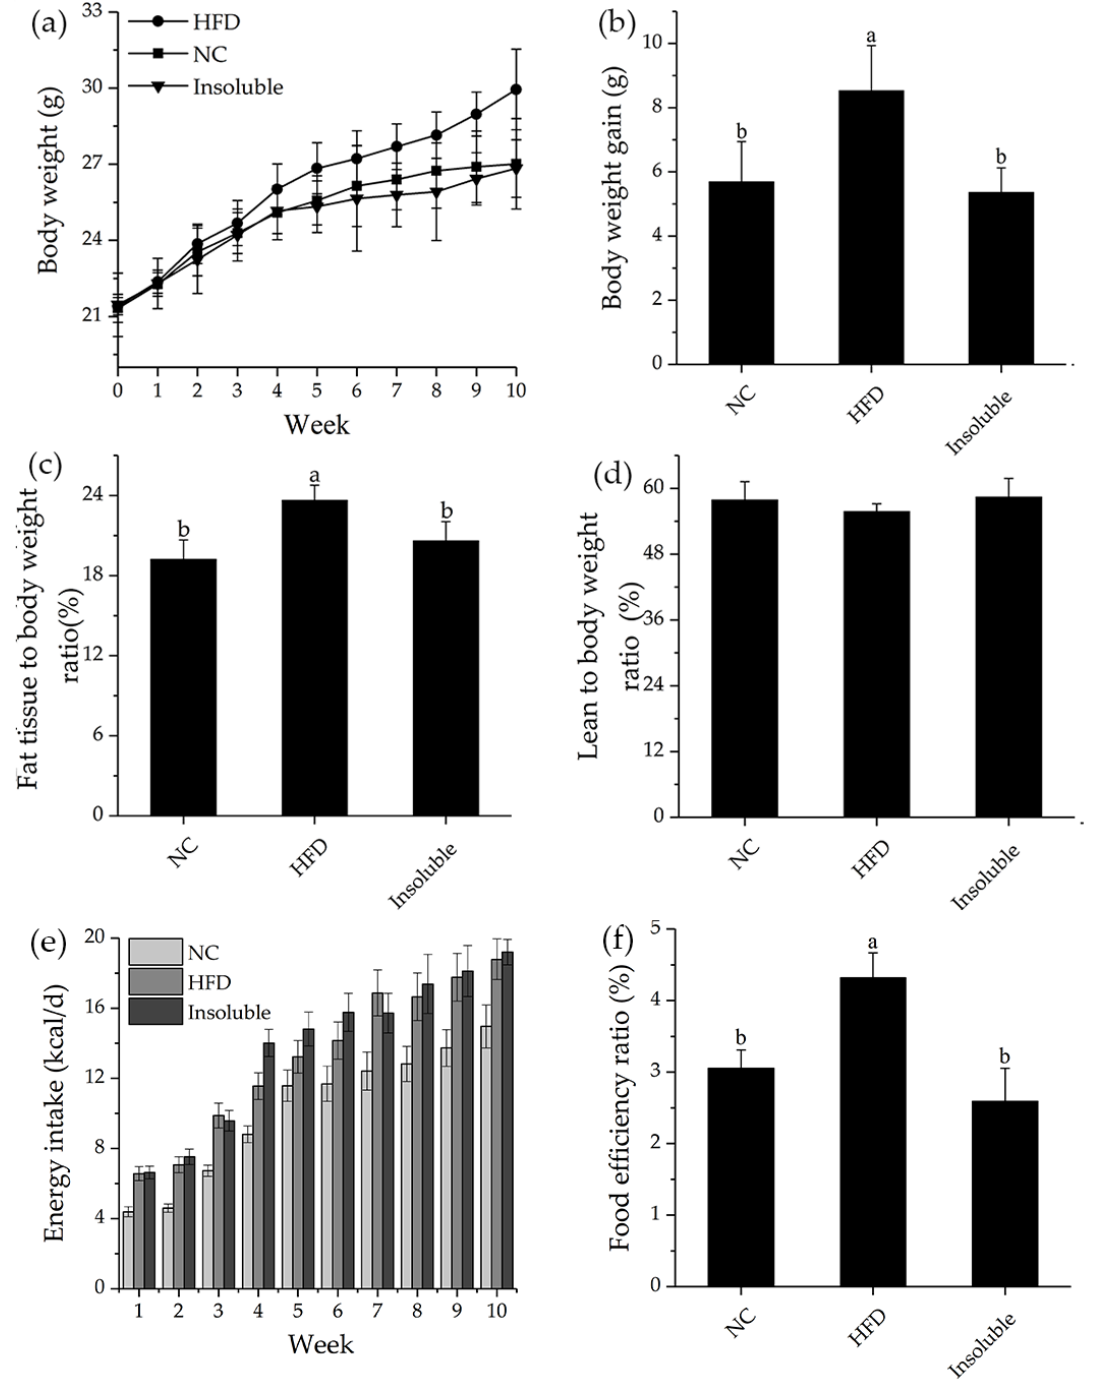
Figure 6. Effect of oral administration of water-insoluble β -glucan on body weight, fat tissue to body weight ratio, lean to body weight ratio, and food intake in HFD-fed mice. ( a ) Changes in body weight over 10 weeks. ( b ) Body weight gain at the end of week 10. Weight gain (%) = [(final weight(g) − initial weight (g))/initial weight (g)] × 100. ( c ) Fat tissue to body weight ratio (%) = fat weight/body weight × 100. ( d ) Lean to body weight ratio (%) = lean meat weight/body weight × 100. ( e ) Daily energy intake of HFD-fed mice. ( f ) Food efficiency ratio (%) = mean body weight gain (g)/mean food consumption ( g ) × 100. NC, normal control group; HFD, obesity model group; Insoluble, mice fed with HFD and given oral administration of water- insoluble β -glucan. Data are presented as mean ± standard deviation (n = 6). Groups labeled with different letters are different from one another ( p < 0.05).